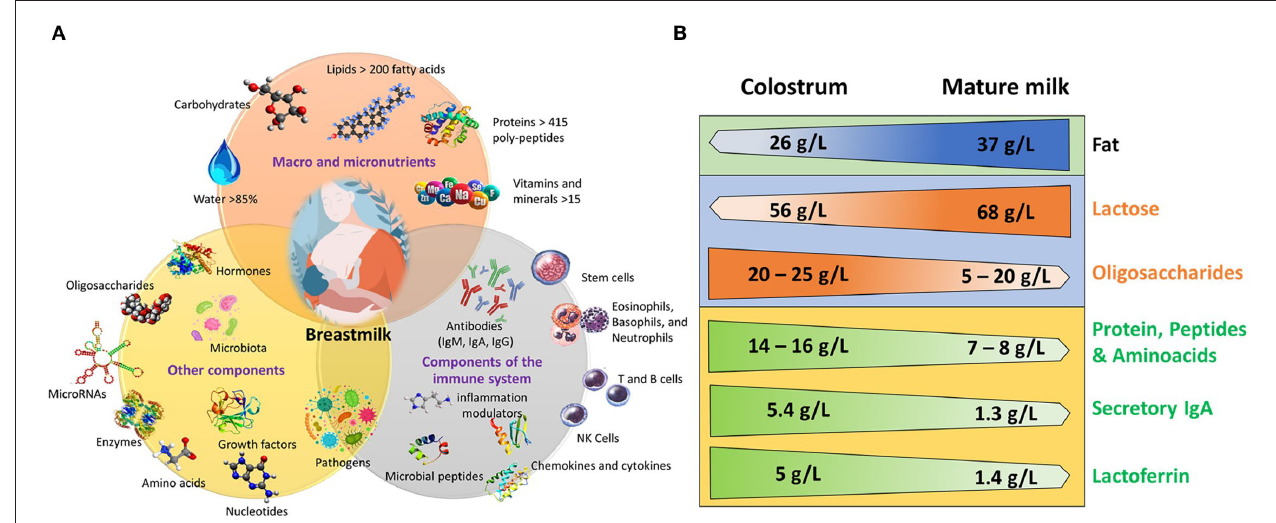
FIGURE 1 | Components of human milk and differences between colostrum and mature milk. (A) Macro and micronutrients, components of the immune system, and other components. Modified from ( 7, 9, 10, 14, 15). (B) Concentration of some components in colostrum and in mature milk. Modified from (4, 11–14, 16). and the first part of the night, then increase again (5, 36).